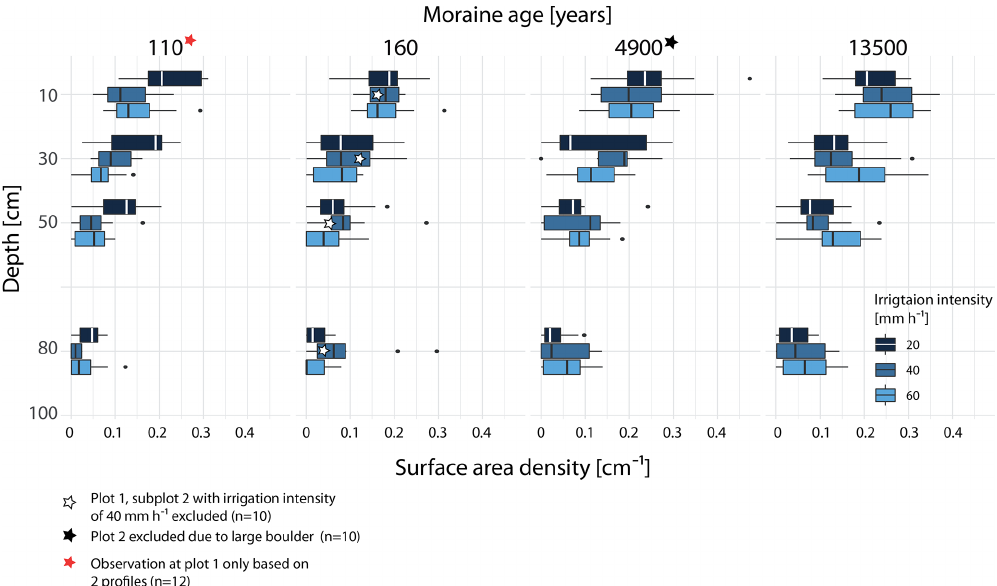
Figure 6. Surface area density (an indicator for the number of flow paths observed across the profile at a certain depth) for the depth increments of 0–20, 20–40, 40–60, and 60–100cm per age class and irrigation intensity. Each box contains the information of the five profiles per subplot ( n =